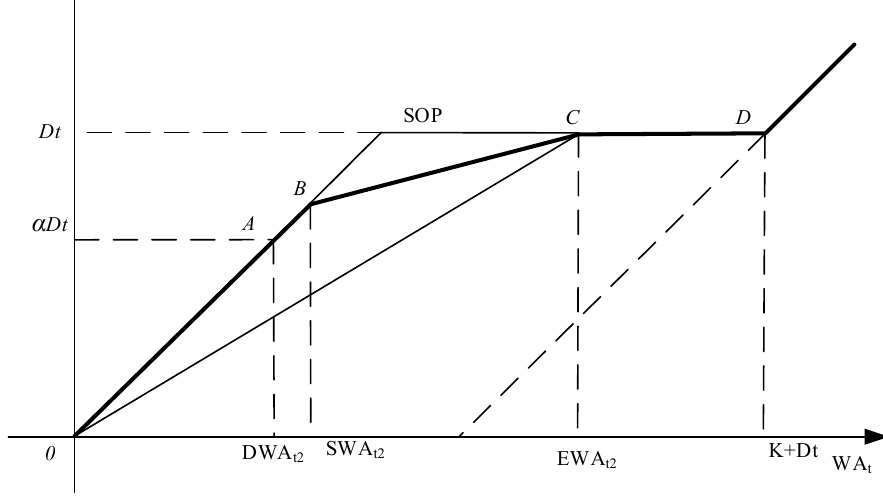
Figure 3. The hedging rules considering allowable damage depth of Situation II.